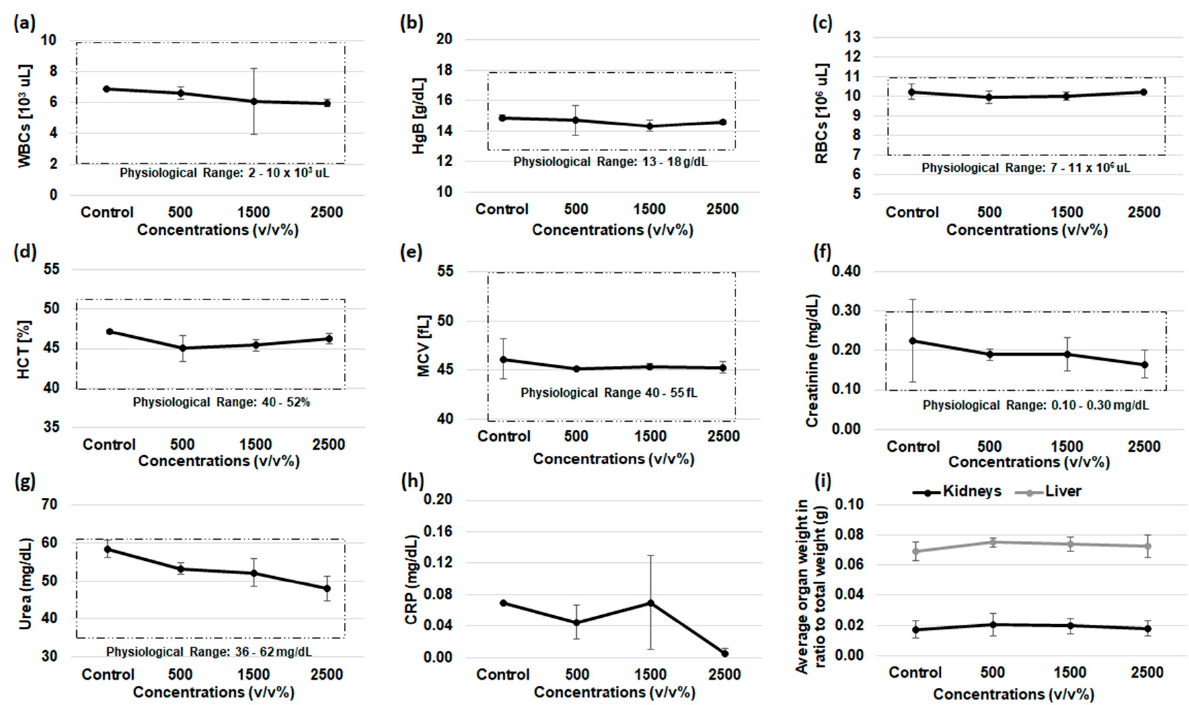
Figure 3. Effect of the test compound on various hematological ( a – e ) and biochemical ( f – h ) param- eters and organ weight ( i ) of mice. All values were within the physiological range and comparable to that of the control group. No statistically significant differences were observed between the two genders. Results are shown as mean ±